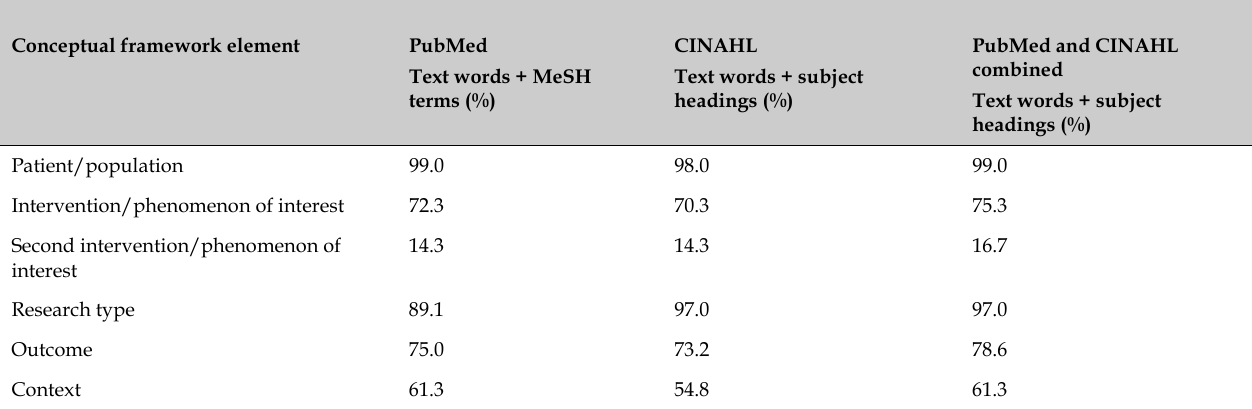
Table 2 Relative recall of conceptual framework elements using both text words and subject headings in PubMed, CINAHL, and both databases combined